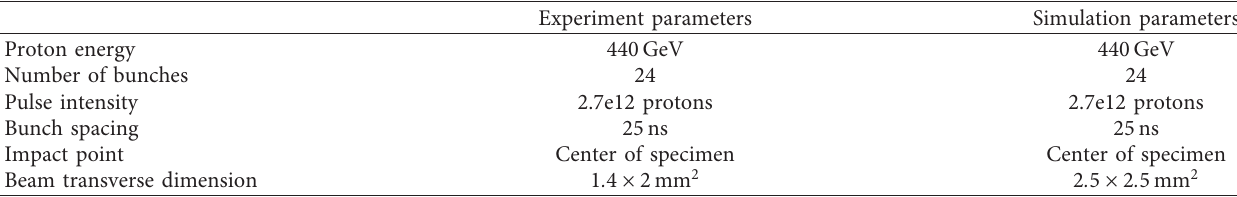
Figure 5: General assembly of the test-bench [15]. Table 3: Beam parameters, medium-intensity tests on Inermet ® 180.